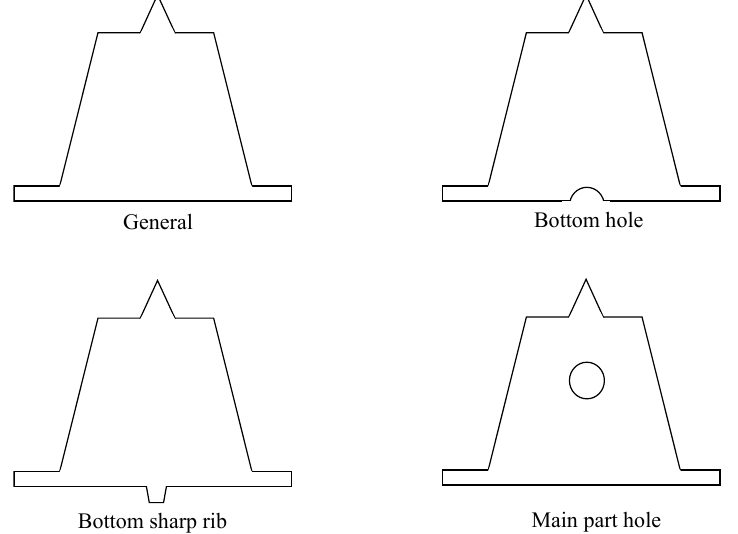
Figure 5. The four typical types of GINA gaskets (redrawn according to Hu et al. [23]). The conclusions are as follows: the type of bottom hole has the best contact with the bottom plate, so the bottom hole can improve the waterproof performance of the bottom plate. The type of sharp bottom rib is easy to overturn in the prophase of compression of the GINA gasket because of the small action area with the steel plate, which will result in poor waterproofing. The type of main part hole can significantly reduce the stress concentration of the sharp rib, which is more beneficial to the long-term waterproofing of the GINA gasket. The traditional type can better withstand the eccentric load.